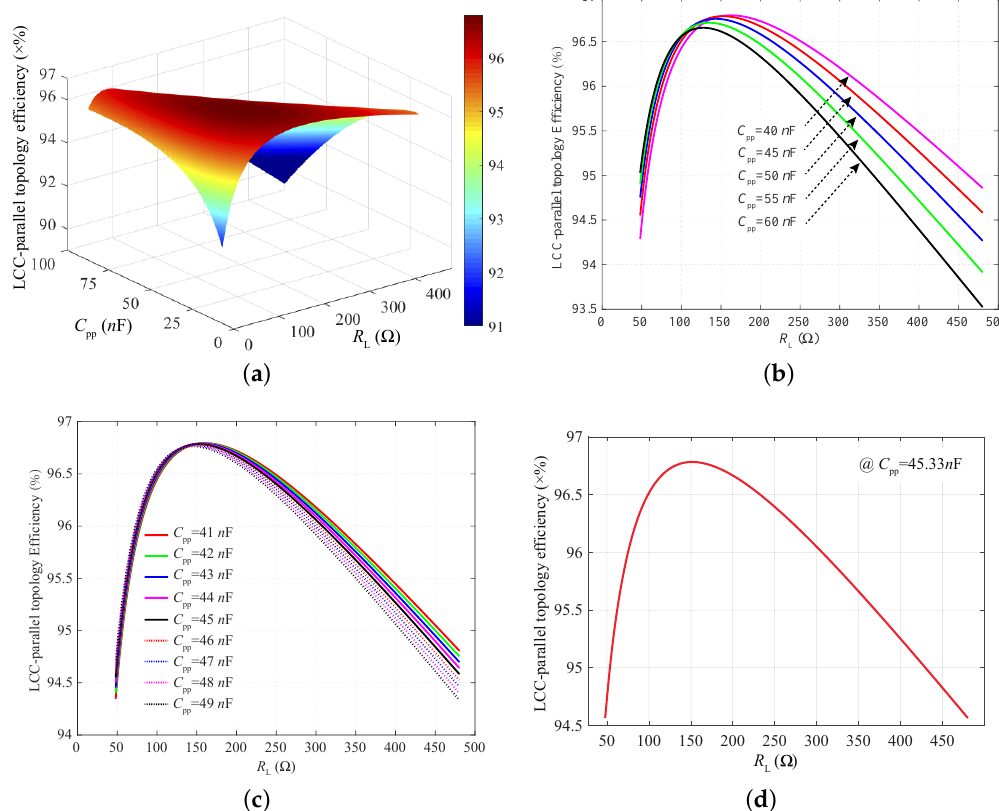
Figure 7. ( a – c ) Optimized efficiency of the LCC-parallel compensation topology ( η ) versus R L and C pp and ( d ) η with respect to R L when C pp is set to 45.33 nF.